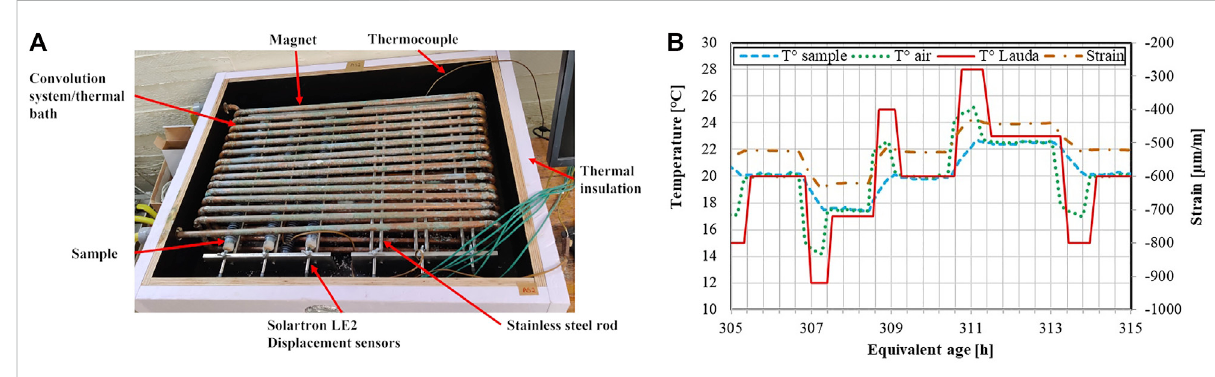
FIGURE 1 AutoShrink device developed at ULB (A) and example of the temperature variations (B)